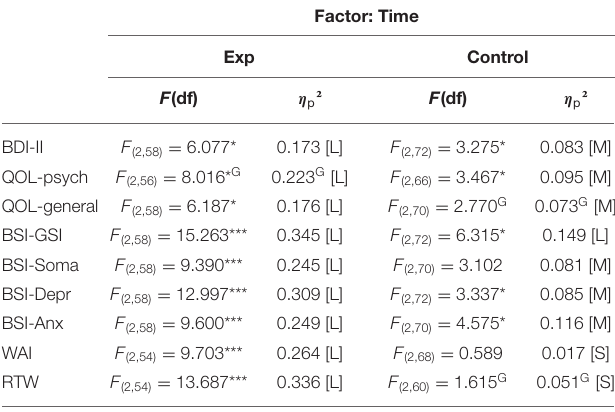
TABLE 3 | Inferential statistics of the experimental variables with the factor time (T0, T1, and